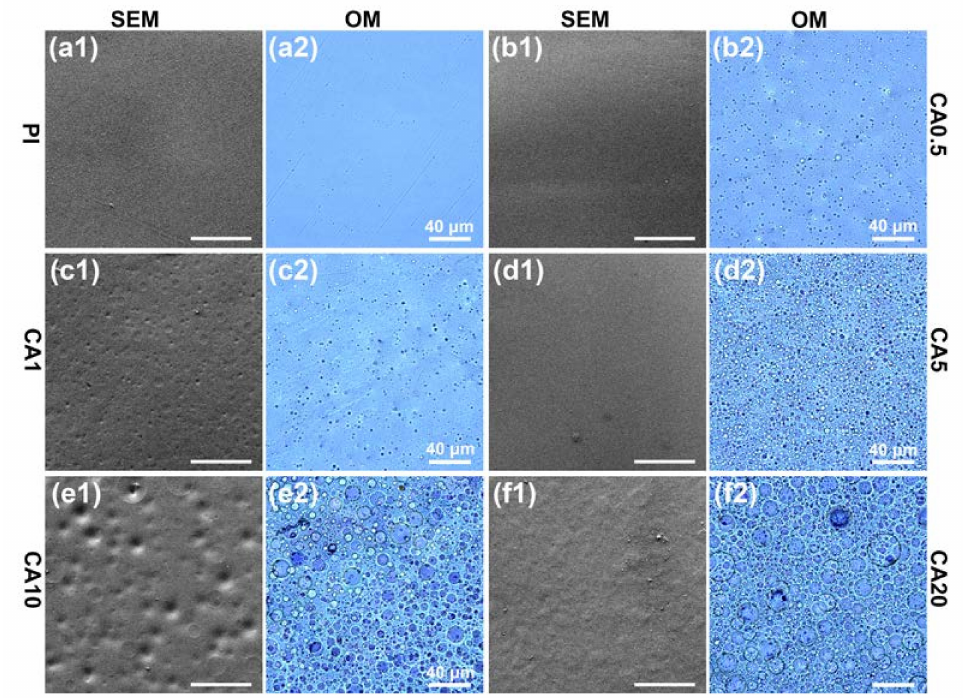
Figure 2. SEM and optical images of composite membranes: ( a 1– f 1) and ( a 2– f 2) are polymer membranes of PI, CA0.5, CA1, CA5, CA10, CA20,